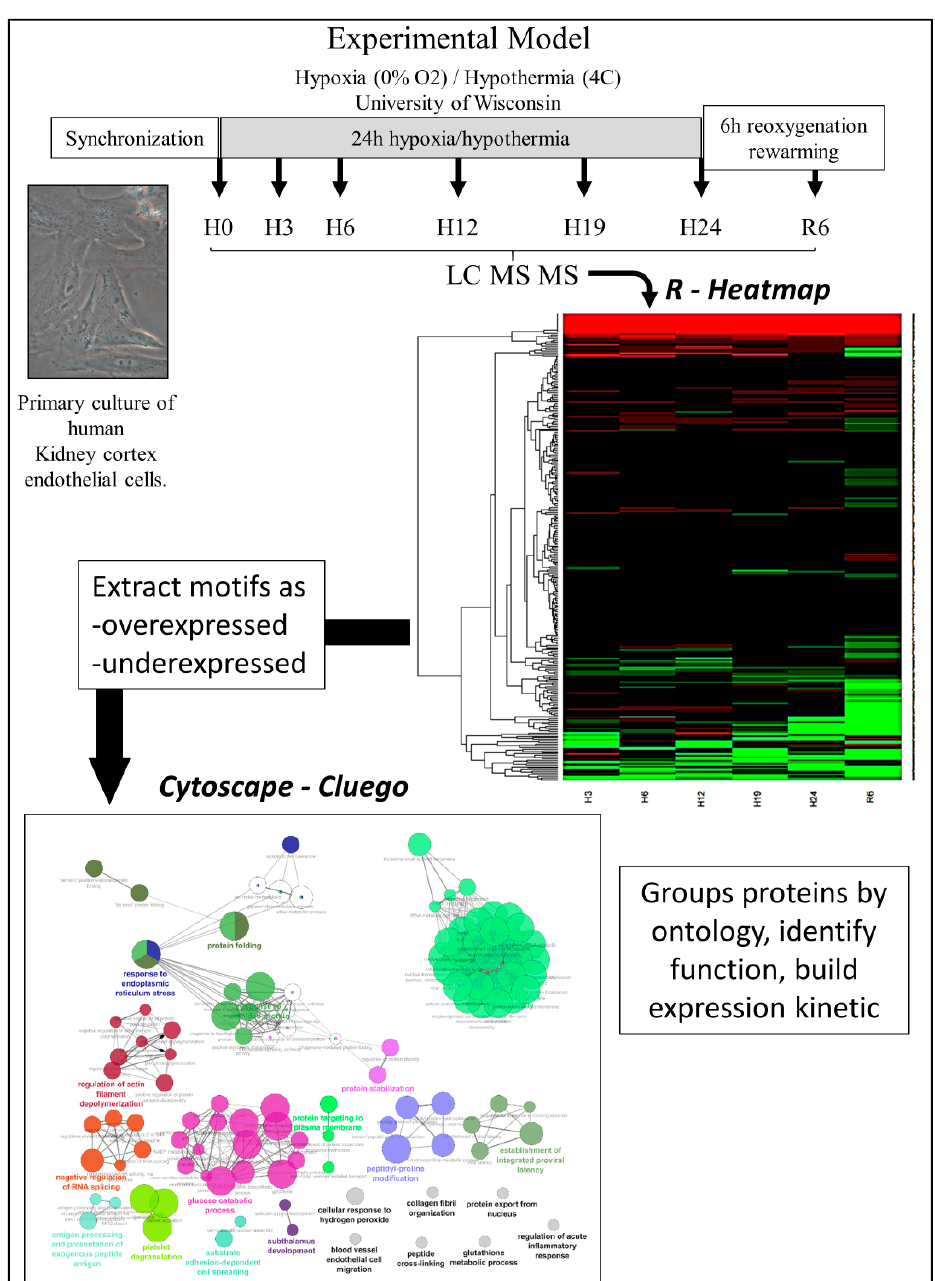
Figure 1. Experimental model and analysis strategy . Primary human renal glomerular endothelial cells (HRGEC) were synchronized and were subjected to cold-ischemia like conditions: incubation in a hermetic chamber at 4 °C containing a hypoxic atmosphere: 0% O 2 , 5% CO 2 , and 95% N 2 for up to 24 h (Hypothermic/Hypoxic period, H), in University of Wisconsin solution, then washed and incubated in regular culture conditions (Reperfusion period, R). At each time point, cell monolayers were collected for analysis. After LC-MS/MS analysis, a heatmap was generated to distinguish protein motifs by their variation, and each group was analyzed using Cytoscape's ClueGO to identify their ontology and network associations.